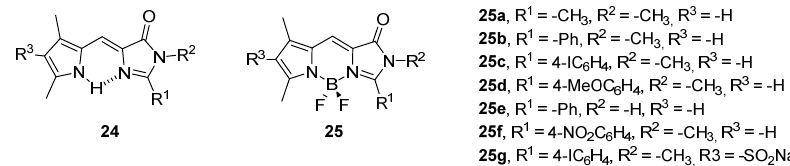
Figure 24. GFPc analogues with a boron complex, demonstrating higher emission intensity than the hydrogen-bonded precursors [9].